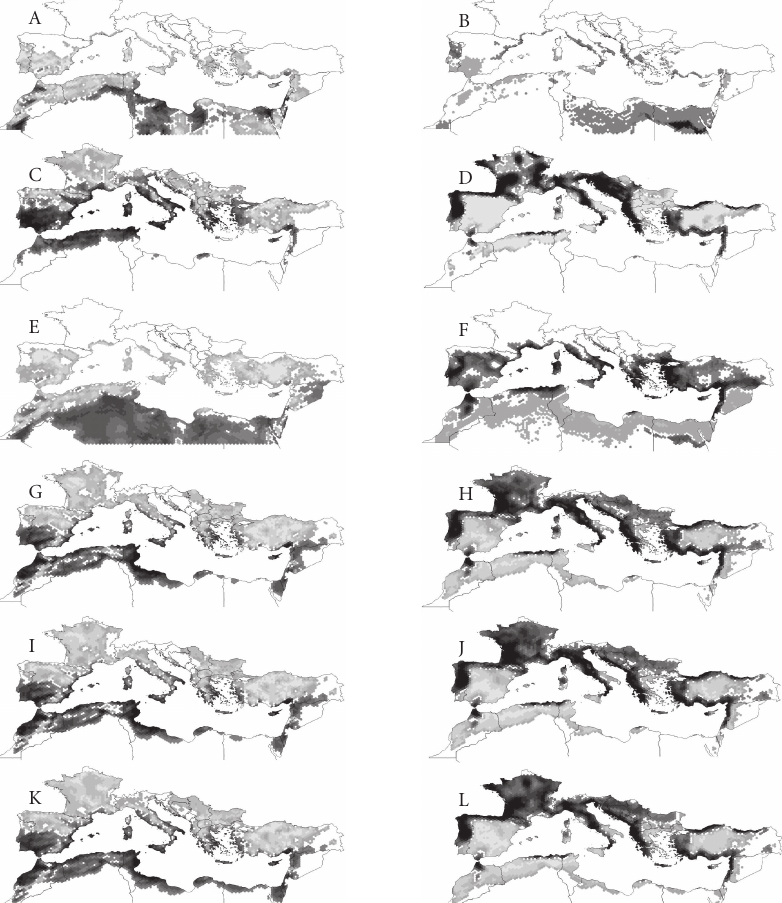
Figure 5: Predicted geographic impact (habitat suitability turnover) of di ff erent climate change scenarios. The maps shows the forecasted changes in habitat suitability for di ff erent tick species, with changes in temperature (left column) or rainfall (right column) analyzed by consensus analysis (a statistical method of classification using multiple input variables) to show the most coherent response to a range of changes in predictor variables. Dark shades of grey indicate increased climate suitability following a decrease in the predictor variable scenario (temperature or rainfall). Light shades of grey indicate increased climate suitability following an increase in the predictor variable. A and B: B. annulatus ; C and D: D. marginatus ; E and F: H. excavatum ; G and H: H. marginatum ; I and J: R. bursa ; K and L: R. turanicus